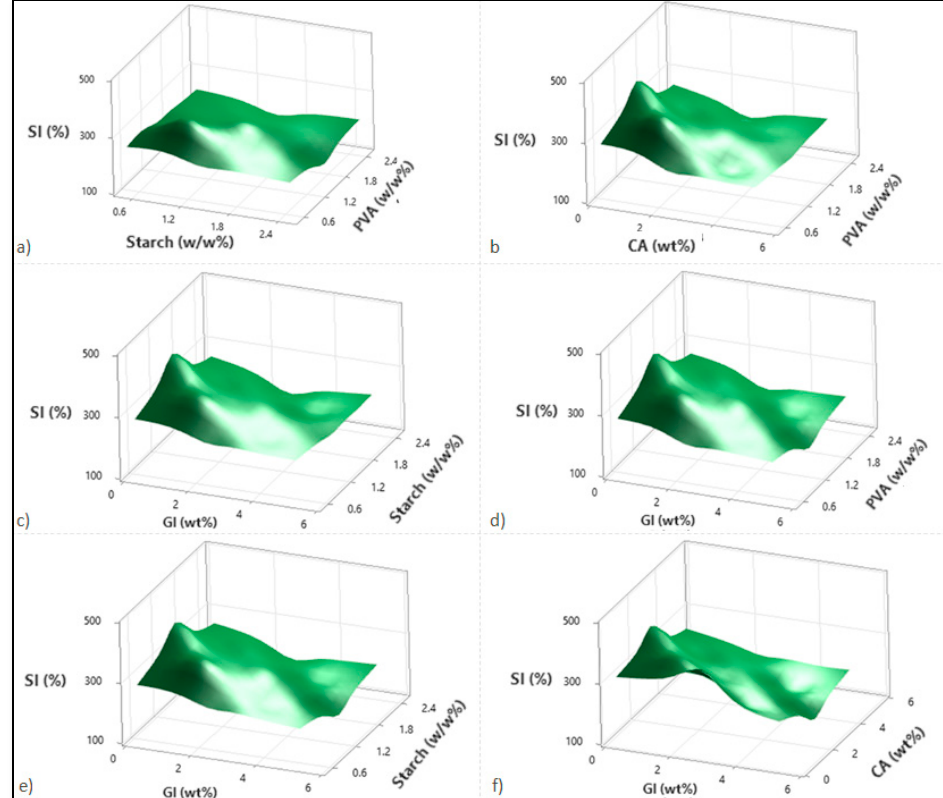
Figure 2. Corresponding response surface plots show the independent variables’ effects on the swelling index (%). ( a ) Starch-PVA, ( b ) Citric acid-PVA, ( c ) Glycerol-Starch, ( d ) Glycerol-PVA, ( e ) Glycerol-Starch, and ( f ) Glycerol-Citric acid.